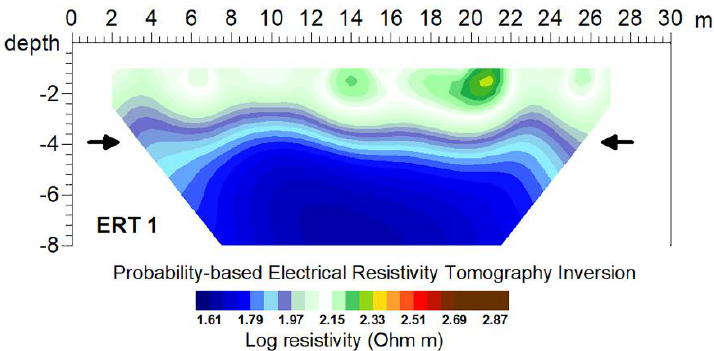
Figure 12. Electrical resistivity tomography (ERT) 1, line 1 in Figure 3.